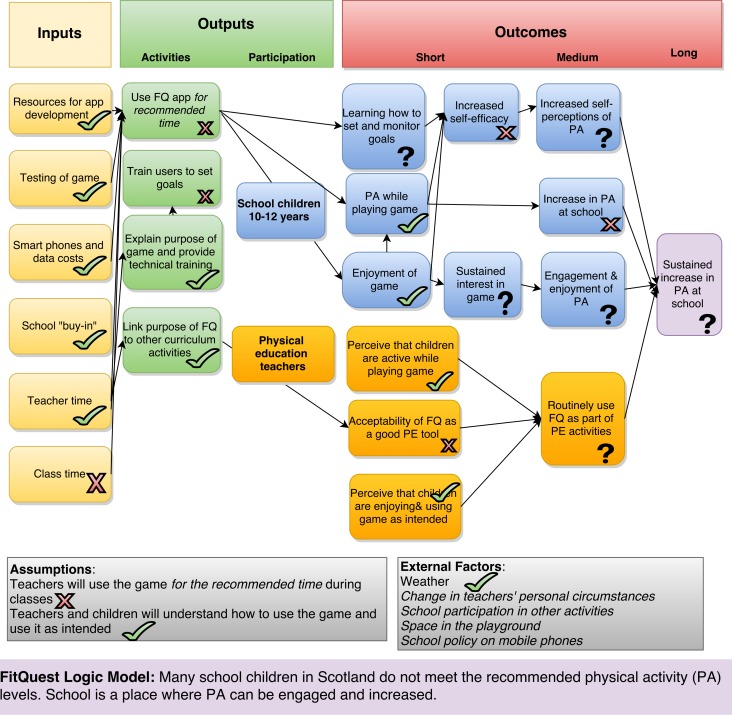
Revised logic model.